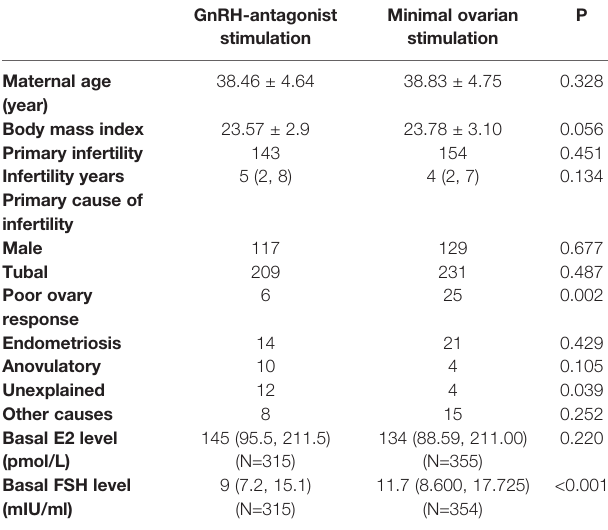
TABLE 1 | Baseline demographic and clinical characteristics based on different